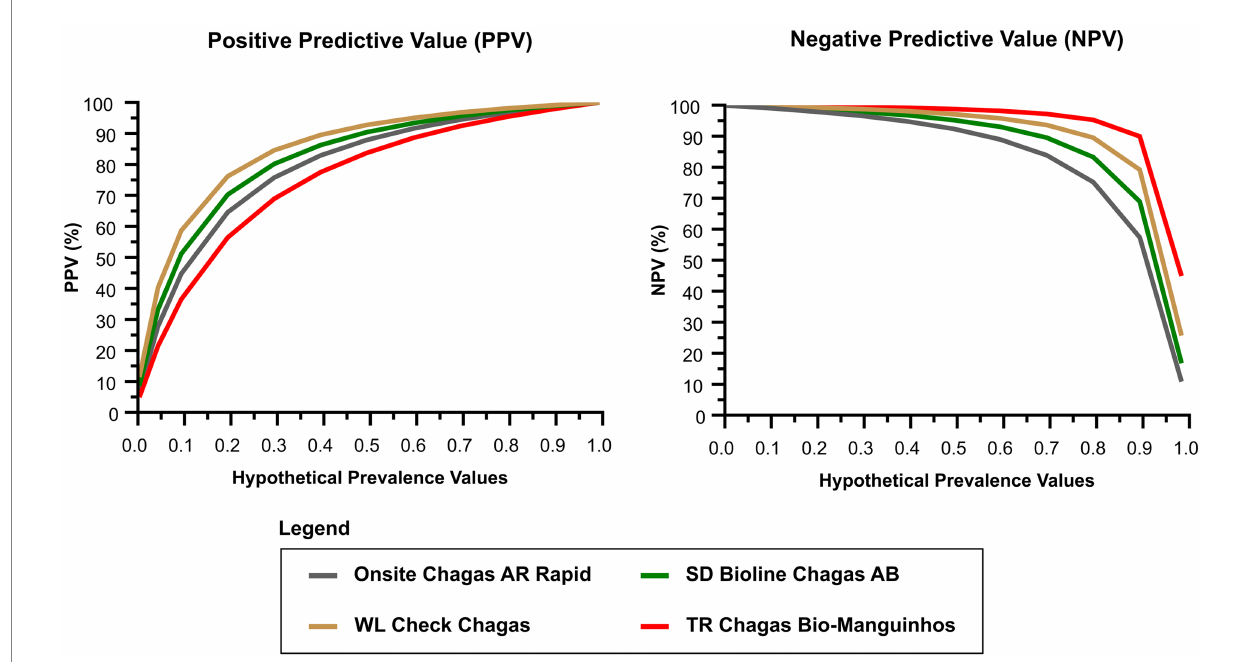
FIGURE 2 Positive and negative predictive estimates for different prevalence scenarios of chronic Chagas disease. NPV, negative predictive value; PPV, positive predictive